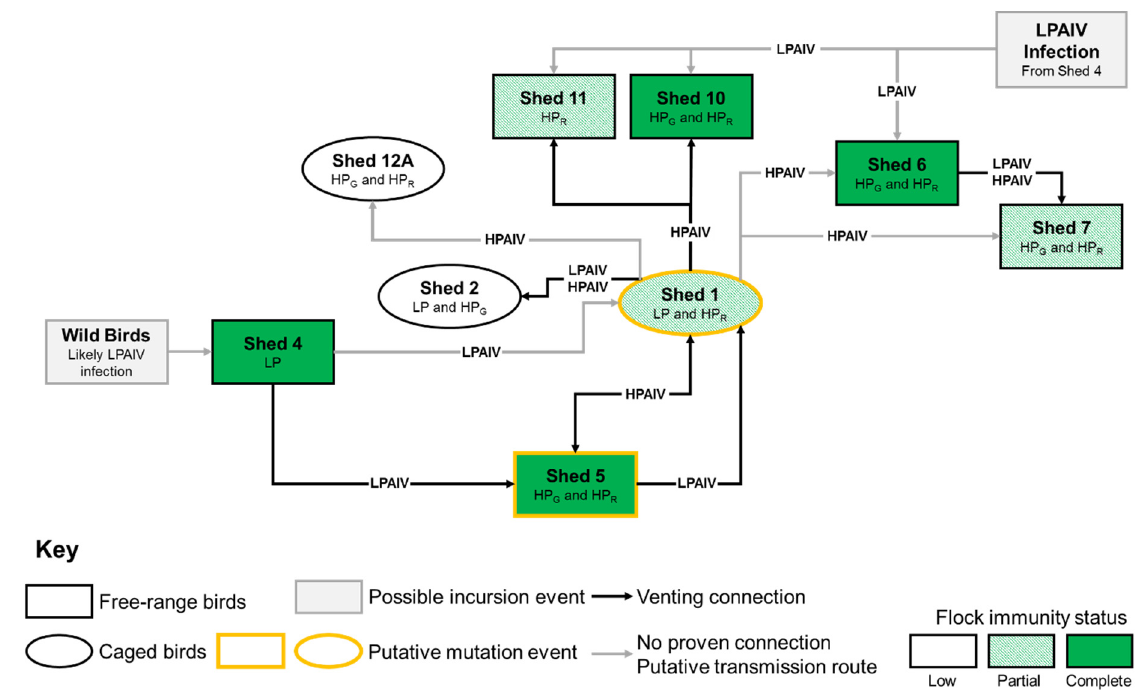
Figure 6. Putative transmission of H7N7 LPAIV and HPAIV through the IP. Molecular and serological investigations of samples collected in Sample Sets 2 and 3, were used to determine the immune and infection status of birds in different sheds on the IP to plot the putative spread of the virues through the different sheds. Flock immunity status per distinct epidemiological group was defined as follows: Low, virus detected and less than 40% seropositive animals; Partial, virus detected and 40–60% seropositive animals; Complete, some virus detected and greater than 60% seropositive animals. Shed 10 had 33% seropositives in Sample Set 2, but 82% in Sample Set 3 and was therefore considered to have complete flock immunity.